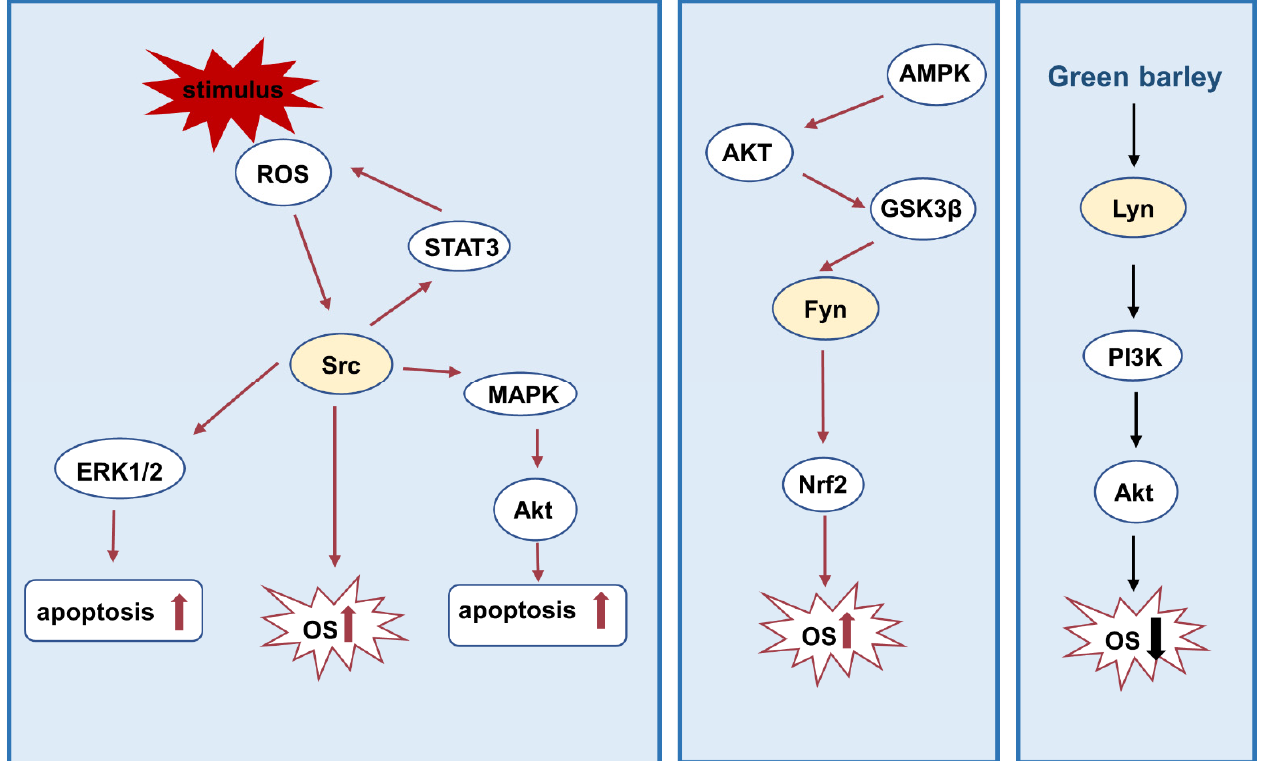
Figure 3. Src family kinases and oxidative stress. Src kinase triggers STAT3, MAPK, Akt signaling pathway activation under ROS stimuli, thus promotes oxidative stress and apoptosis. Fyn promotes oxidative stress mainly by Nrf2. On the contrary, the activation of Lyn alleviates oxidative stress through the PI3K/Akt pathway. Abbreviations: GSK-3 β : glycogen synthase kinase-3beta.